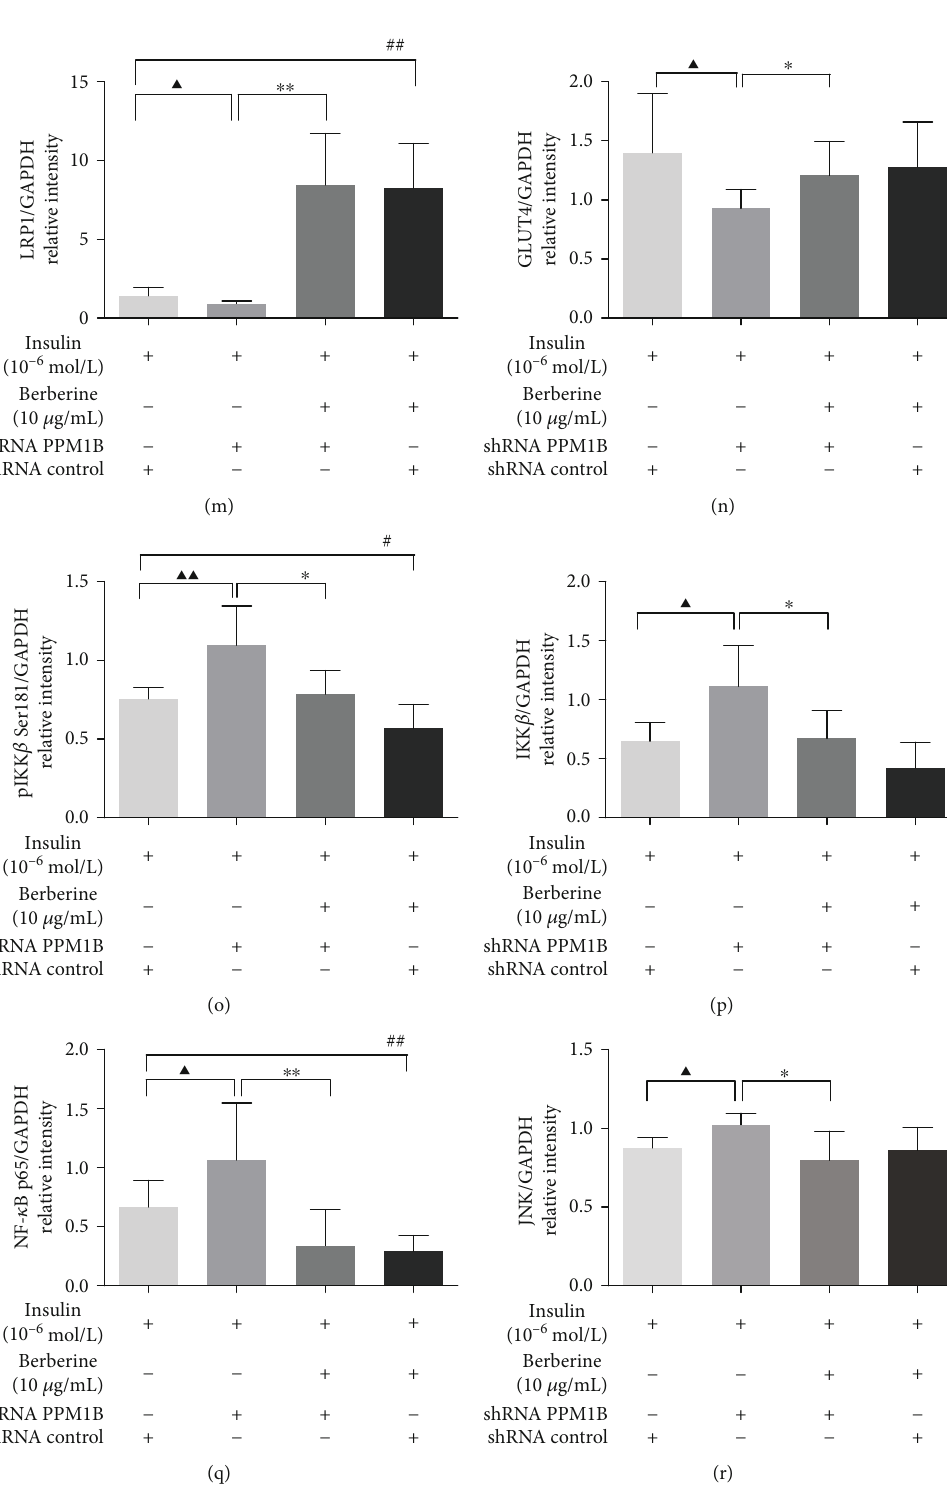
Figure 11: E ff ect of BBR on the relative expression of PPM1B, PPAR γ , LRP1, GLUT4, IRS-1, IRS-2, PI3K, AKT, pIKK β Ser181, IKK β , NF- κ B p65, and JNK in HepG2-IR cells with silenced PPM1B by lentivirus. GAPDH was utilized as an internal reference. Data were obtained by measuring the gray value of each bar from the result of Western blotting and were presented as the fold change relative to that of GAPDH. ▲ P < 0 : 05 and ▲▲ P < 0 : 01 , shRNA control group vs. shRNA PPM1B group; ∗ P < 0 : 05 and ∗∗ P < 0 : 01 , shRNA PPM1B+BBR group vs. shRNA PPM1B group; # P < 0 : 05 and ## P < 0 : 01 , shRNA control+BBR group vs. shRNA control